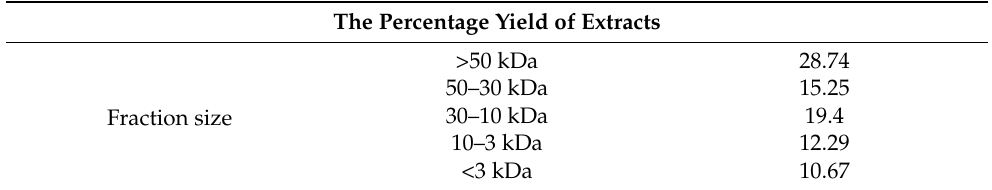
Table 2. The percentage yield of HRBE fractions.